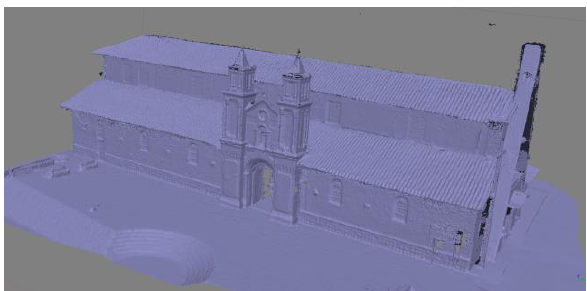
Figure 9 . Nabón’s church 3D model